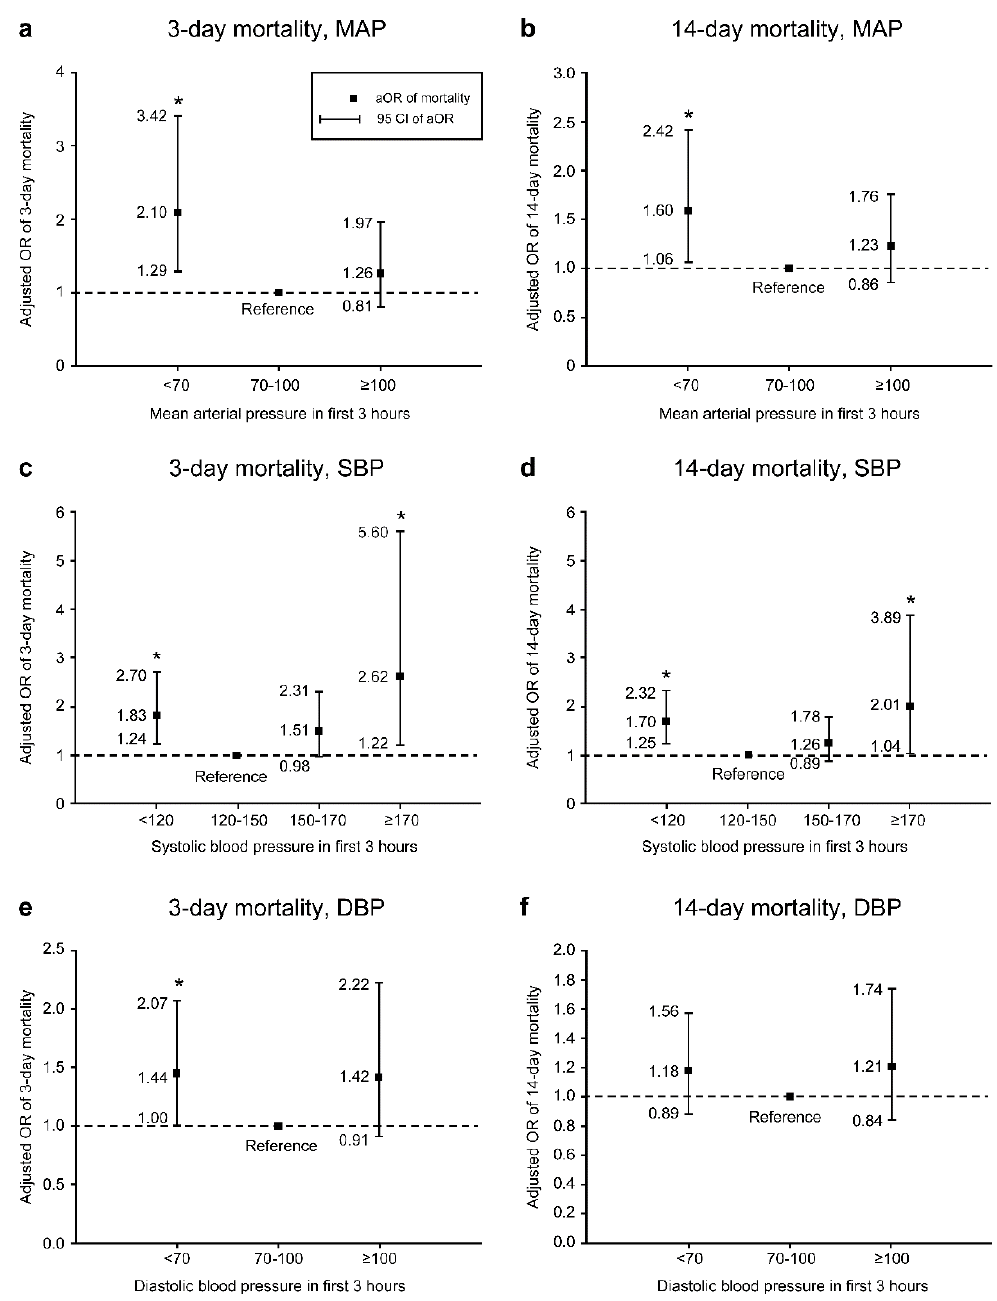
MAP, mean arterial pressure; SBP, systolic blood pressure; DBP, diastolic blood pressure; OR, odds ratio; CI, confidence interval.